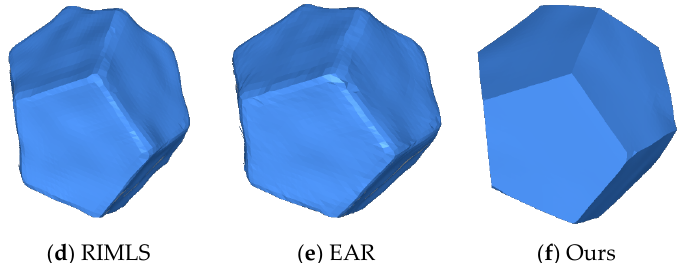
Figure 6. The Twelve model corrupted by impulsive noise ( σ = 0.5 h) in the normal direction. We can see that the proposed method was able to preserve sharp features effectively when compared to the state-of-the-art methods. The surface was reconstructed using the ball pivoting algorithm.